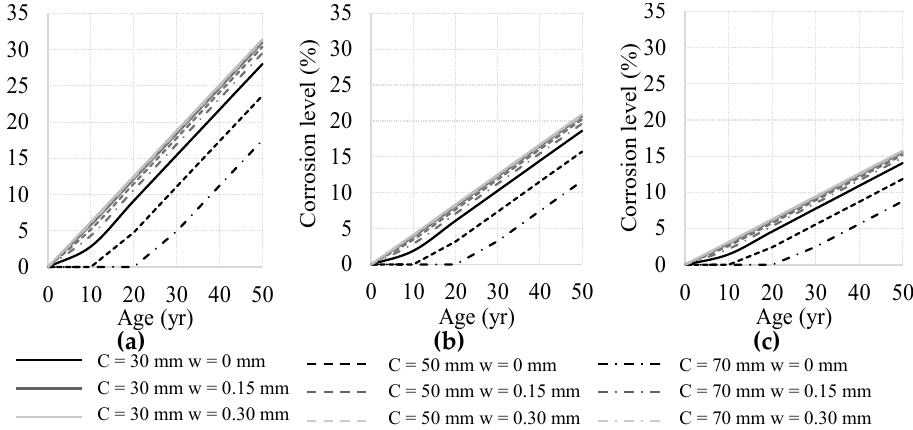
Figure 14. Corrosion level of evaluated sections: ( a ) ϕ = 12.7 mm; ( b ) ϕ = 19.1 mm; ( c ) ϕ = 25.4 mm.